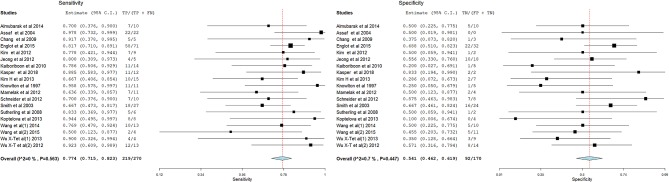
Forest plot showing sensitivity and specificity of the II-MSI studies (individual studies: size of the squares are proportional to weights used in meta-analysis; the summary measure: center line of the diamond; associated 95% confidence intervals: lateral tips of the squares and the diamond).